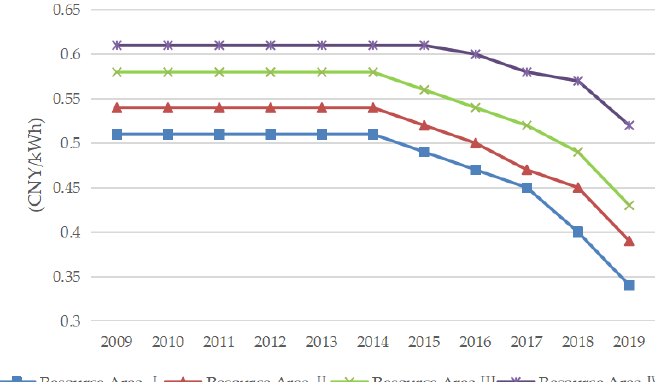
Figure 3. Feed-in tariff of China wind power in 2010–2019 (CNY/kWh). (2)